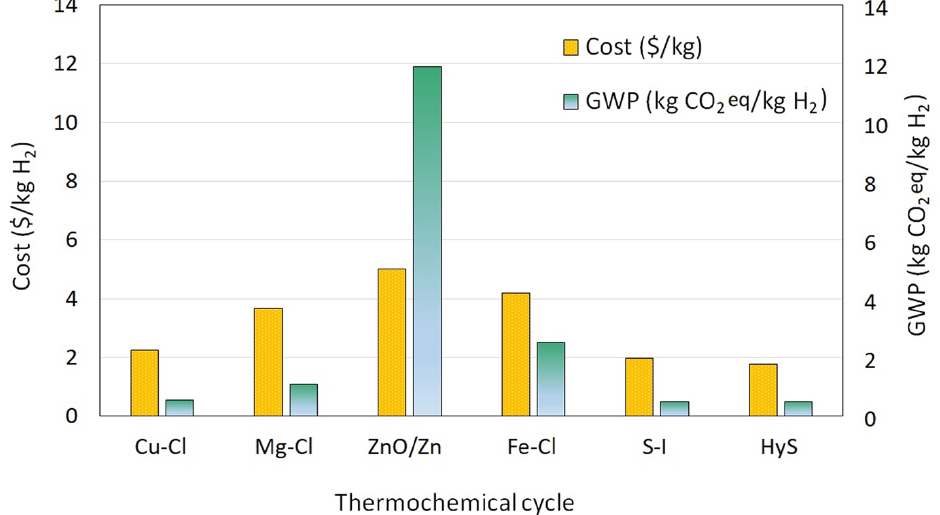
Figure 9. GWP and hydrogen production costs for different thermochemical cycles (Reproduced with permission form [176], Elsevier; 2020).